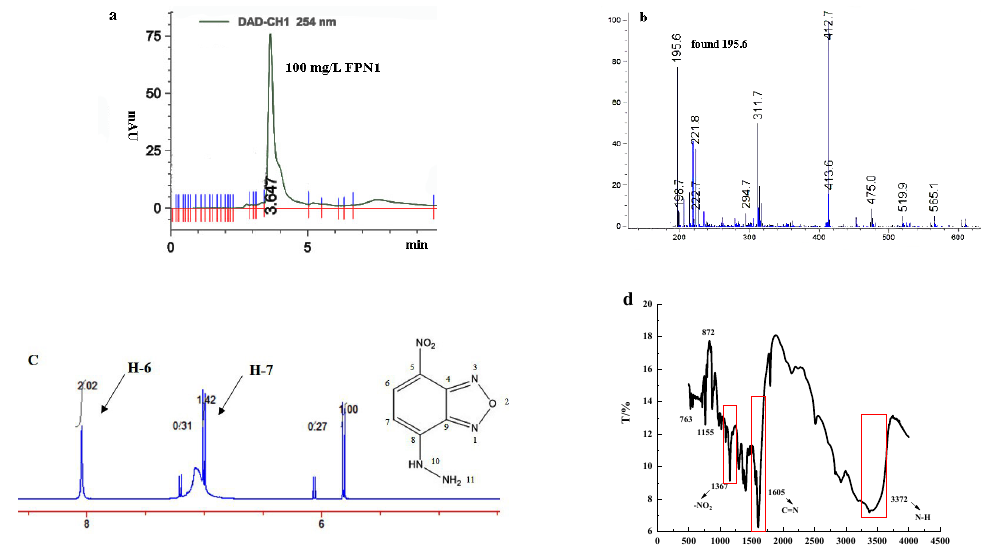
Figure 3. ( a ) HPLC spectrum of FPN1. ( b ) HRMS spectrum of FPN1. ( c ) 1 H NMR spectrum of FPN1. ( d ) IR spectrum of FPN1. 1 H NMR (300 MHz, DMSO), δ 8.08 (ppm): (d, J = 10.8 Hz, 2H), 7.02 (d, J = 10.8 Hz, 1H). HRMS (ESI): calculated for [M + H]+ 195.04, found 195.6. All the key groups ( ‐ NO 2 , C=N and ‐ NH) could be observed on the IR spectrum.